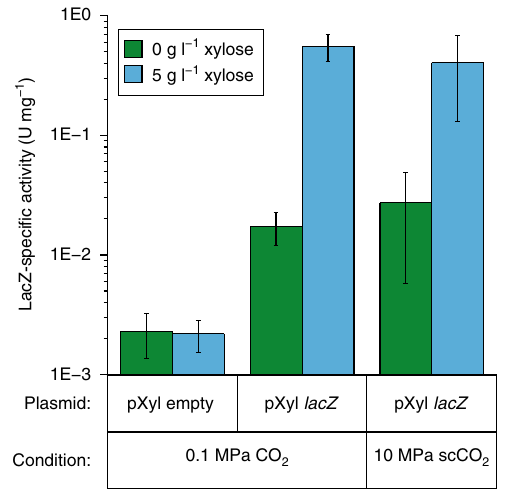
Fig. 3 β -Galactosidase activity for SR7 cultures grown under 0.1 MPa CO 2 and 10 MPa scCO 2 at 37 °C. Speci fi c β -galactosidase activity measured in lysates of SR7 cultures that contain an empty pXyl plasmid or pXyl lacZ . Activity was normalized to total protein concentration in the lysate to control for growth differences and differential cell lysis. Errors represent standard deviation of biological replicate cultures ( n > 4). For cultures grown under 0.1 MPa CO 2 , overnight anaerobic cultures grown from spores were subcultured into CO 2 -evacuated vials to a uniform optical